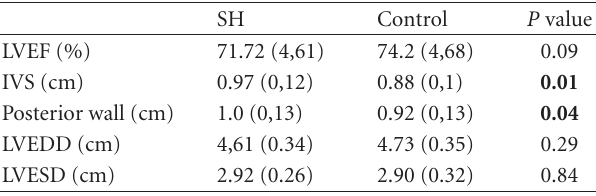
Table 2: Two-dimensional (2D) echocardiographic findings.